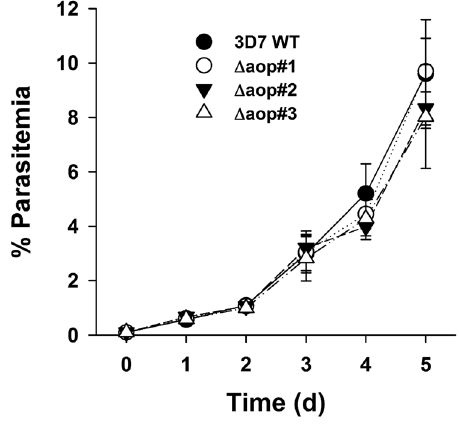
Figure 5. Growth curve analysis. The parasitemia in standard blood stage cultures of strains Δ aop#1-3 from Fig. 4 was determined by counting parasites from Giesma-stained blood smears. Wild type strain 3D7 served as a control. All data are the mean ± standard deviation of triplicate measurements for each strain. None of the differences between the parasitemias was found to be significant (p > 0.05) based on statistical analyses in SigmaPlot 12.5 using the one way ANOVA